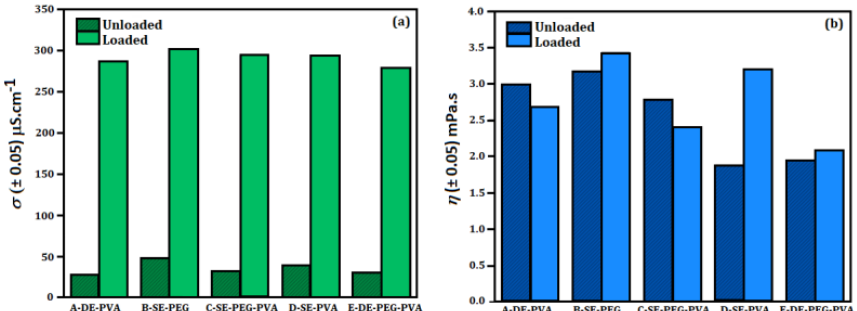
Figure 2. ( a ) Electrical conductivity ( σ ) and ( b ) dynamic viscosity ( η ) of System A (A–DE–PVA), System B (B–SE–PEG), System C (C–SE–PEG–PVA), System D (D–SE–PVA) and System E (E–DE–PEG–PVA).